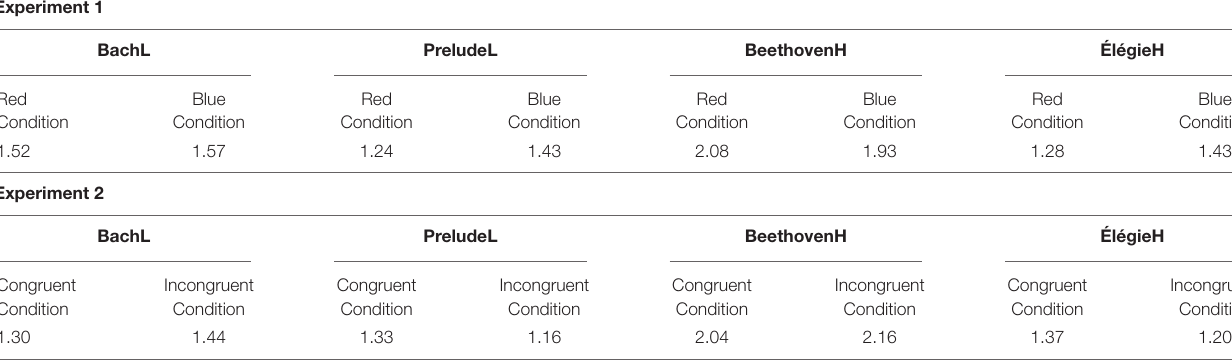
TABLE 2 | Mean ratings of familiarity (Experiment 1 and